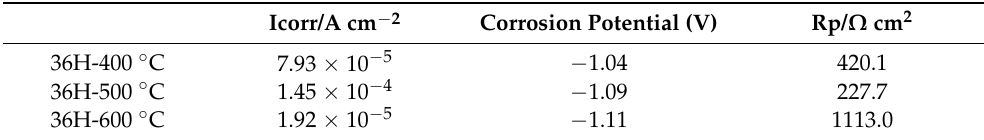
Figure 12. PDP curves of WB zinc − based coatings baked at different temperatures: 36H − 400 ◦ C, 36H − 500 ◦ C and 36H − 600 ◦ C. Table 2. The electrochemical parameters of WB zinc-based coatings baked at temperature after storage for 36 h calculated from Tafel